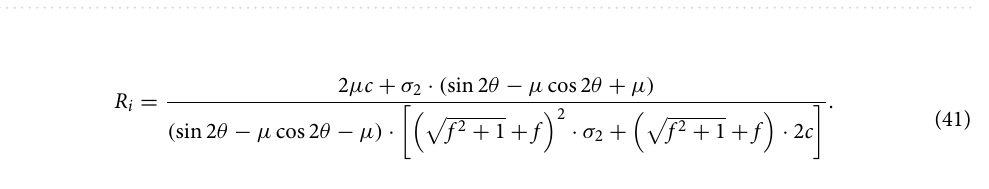
Table 3.. Mechanical parameters used in our